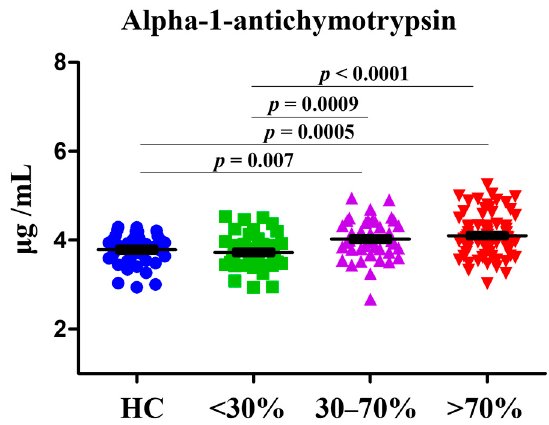
Figure 1. Dot plot of plasma AACT concentrations in healthy controls (HCs), CAD patients with stenosis rates <30%, 30–70%, and >70%. Table 2. The receiver operating characteristic (ROC) curve analysis of AACT. Cut-Off